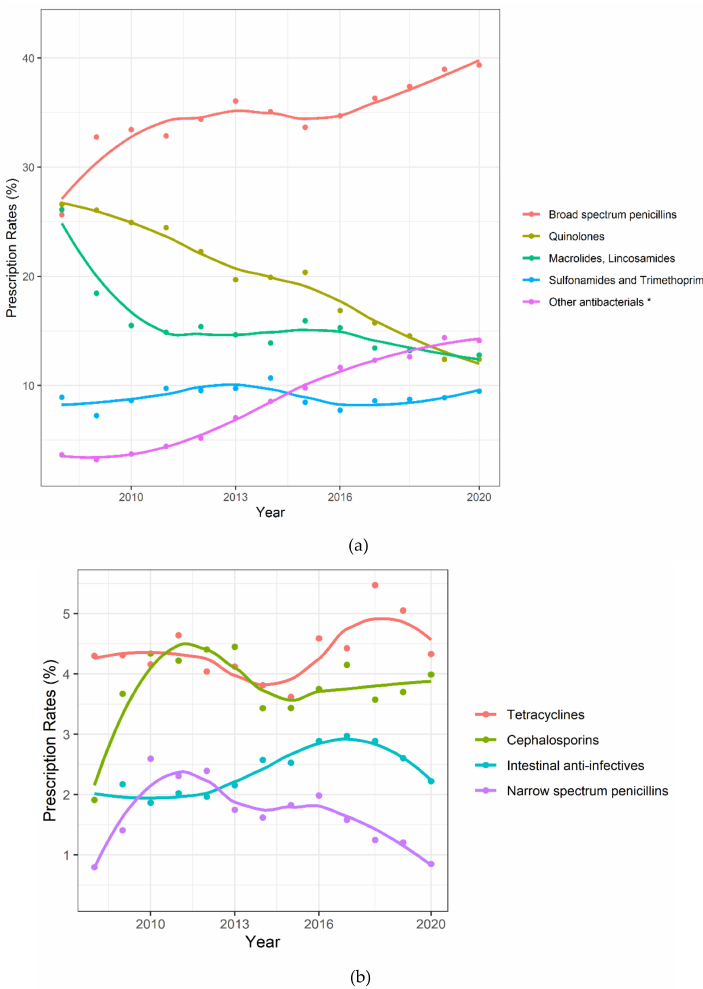
Figure 2. Time trends in antibiotic prescribing in primary care. Points are yearly observed numbers and lines are smoothed curves. ( a ) Antibiotics with > 10,000 prescriptions; ( b ) Antibiotics with > 1000 prescriptions. * This group contains prescriptions from the ATC group J01XB-J01XX. The prescriptions reported in this group consist of > 98% nitrofurantoin and fosfomycin